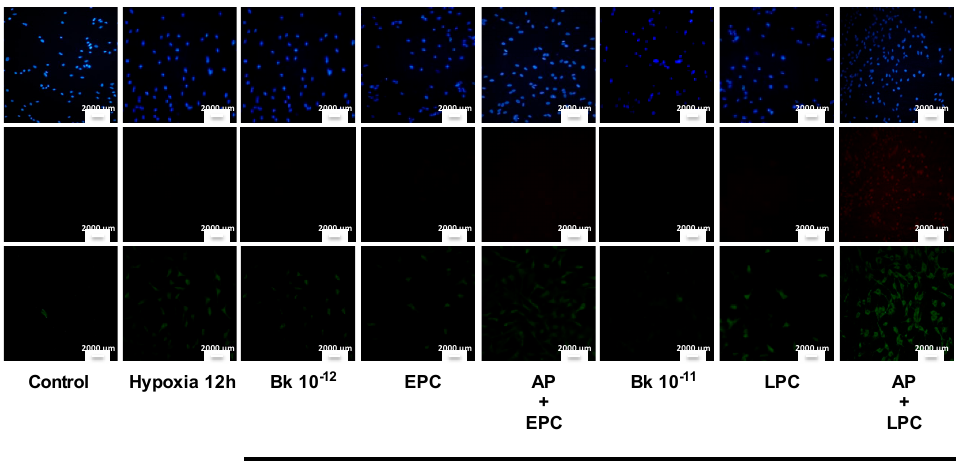
Figure 2. Cells were subjected to prolonged hypoxia (12 h) after early and late preconditioning (EPC and LPC), in the absence and presence of aprotinin (KLK1 selective inhibitor), and after exogenous bradykinin (Bk) administration (10 − 12 and 10 − 11 M), as described in the text. Apoptosis was assessed using Annexin V (green), and necrosis was assessed using Propidium Iodide (red) (PI) staining; nuclei were stained with DAPI (blue). The rates of apoptosis and necrosis were calculated by dividing the number of Annexin-V-positive / PI-negative cells and Annexin-V-positive / PI-positive cells, respectively, by the total number of nuclei detected with DAPI staining. The percentage of apoptotic and necrotic cell death was calculated from six independent experiments. Quantification of apoptosis and necrosis is reported in Table S1 of Supplementary Material. KLK1: tissue kallikrein. The size of the scale bar is 2000 µm.